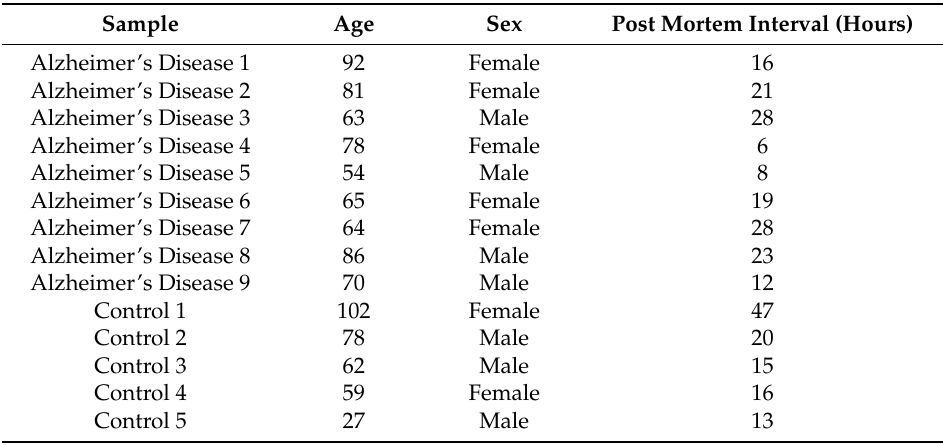
Table 1. Disease status, demographic details and post mortem interval for human samples used in Experiment